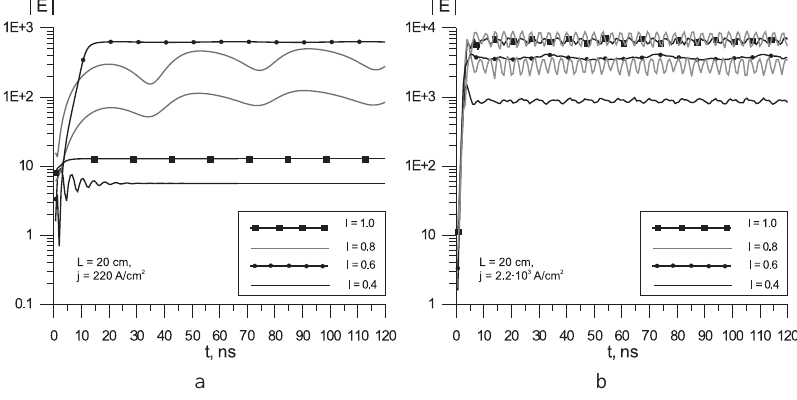
Figure 4. Numerical solution for different detuning parameter l in Bragg geometry.